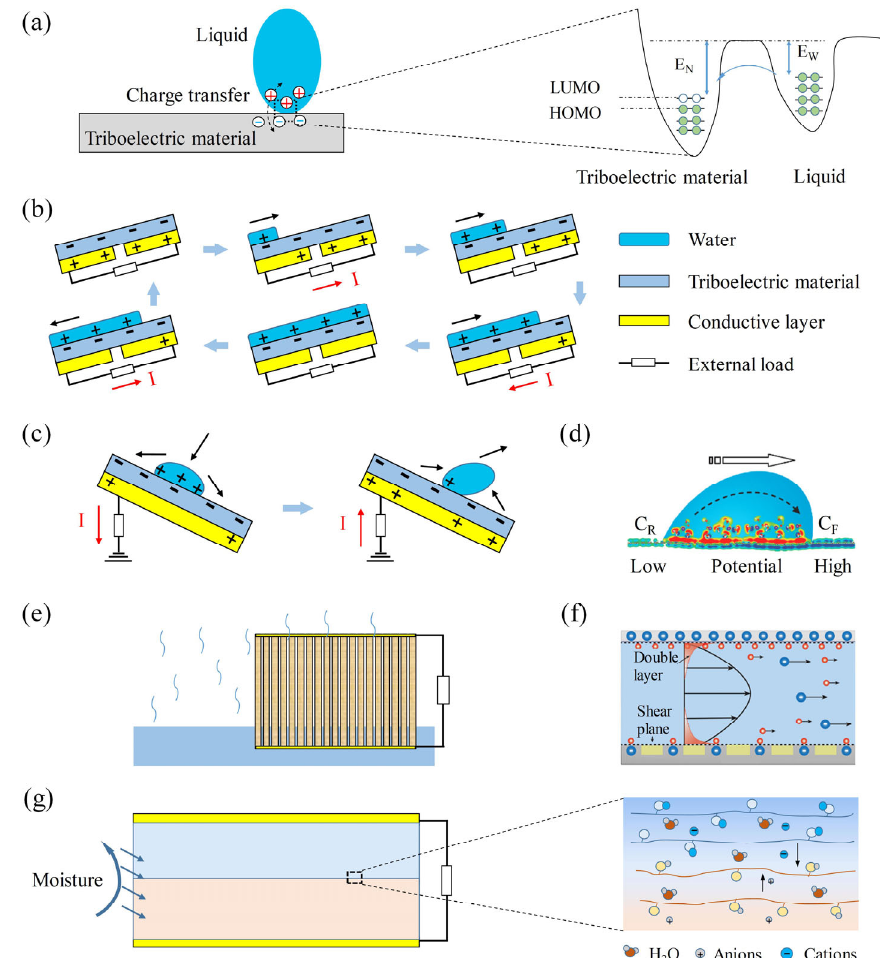
Figure 2 Mechanism of water-driven electricity generator. (a) Electron cloud model of electron transfer between the liquid and triboelectric material. (b) Mechanism of the flowing water-driven electricity generator. (c) Mechanism of the rainwater-driven electricity generator with the conductive layer. (d) Mechanism of the rainwater-driven electricity generator without the conductive layer. Reproduced with permission from Ref. [53], © Nature Publishing Group 2014. (e) Schematic of the evaporation-driven electricity generator. (f) Mechanism of the evaporation-driven electricity generator. Reproduced with permission from Ref. [70], © American Chemical Society 2019. (g) Mechanism of the moisture-driven electricity